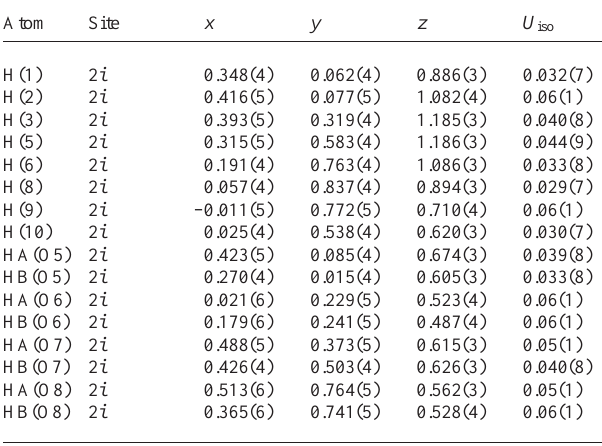
Table 2. Atomic coordinates and displacement parameters (in Å 2 )